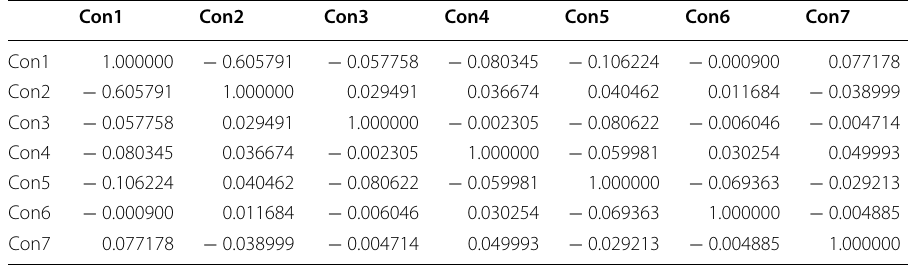
Table 4 Correlation coefficient utilizing the dataset of user U1